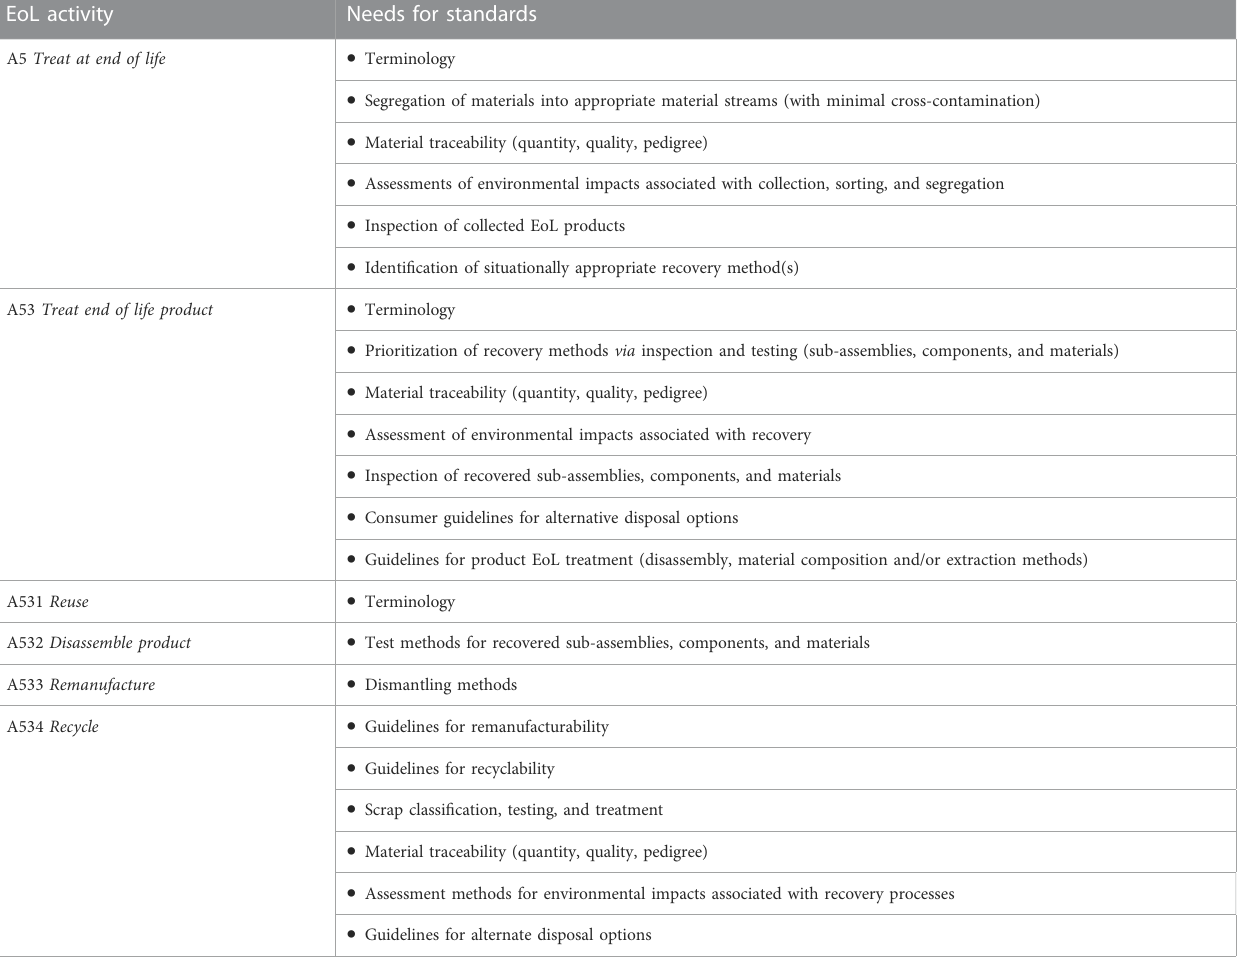
TABLE 2 An overview of the standards gaps during product EoL